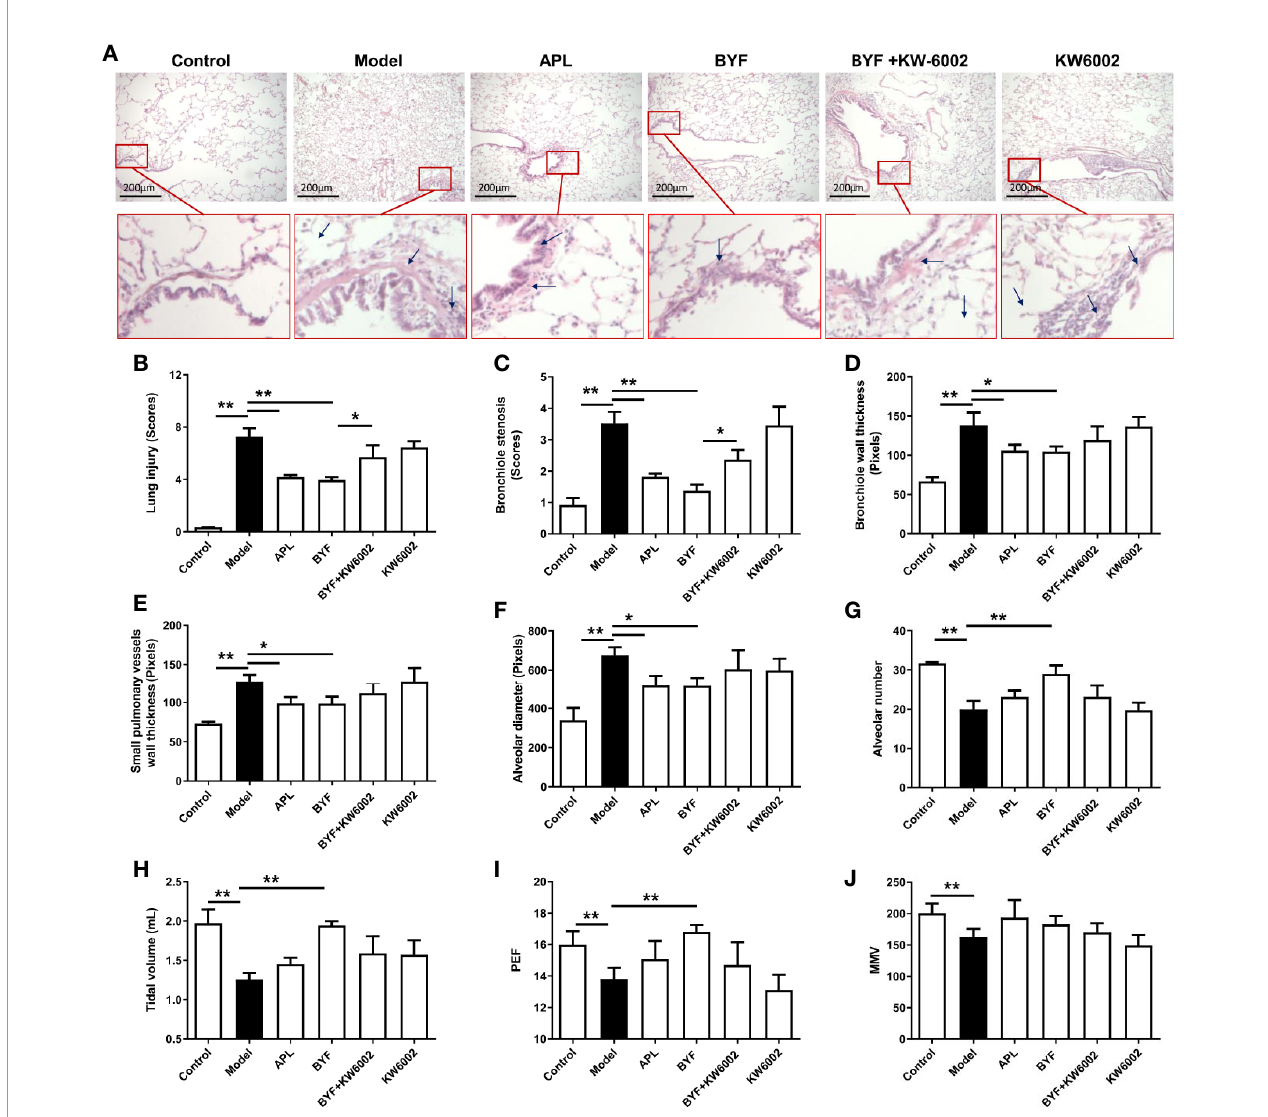
FIGURE 4 | Effect of cotreatment of Bufei Yishen formula (BYF) and A2aR antagonist on chronic obstructive pulmonary disease (COPD) in rats. COPD rats were orally administrated with BYF, KW6002 and aminophylline. (A) Histopathological changes of lung tissues of each group (HE staining, magni fi cation, ×100). (B) Statistics of lung injury scores, (C) bronchiole stenosis, (D) bronchial wall thickness, (E) Small pulmonary vessels wall thickness, (F) alveolar diameter, (G) alveolar number, (H) Tidal volume (TV), (I) Peak expiratory fl ow (PEF), (J) Maximum minute ventilation (MMV). All data are presented as mean ± SEM. N = 6 for each group. *P < 0.05, **P <